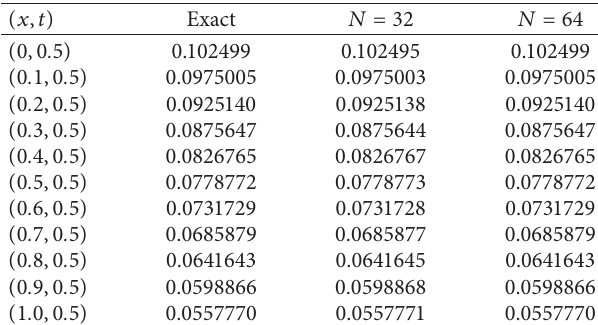
Table 2: Numerical results for Example 1 using two different values � 0 . 5and μ � 0 . of N when T 0